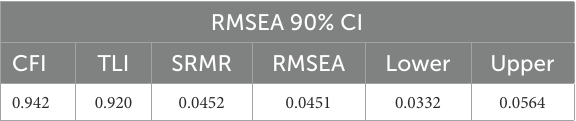
TABLE 2 Fit results for IQIB-ECEC 19-item